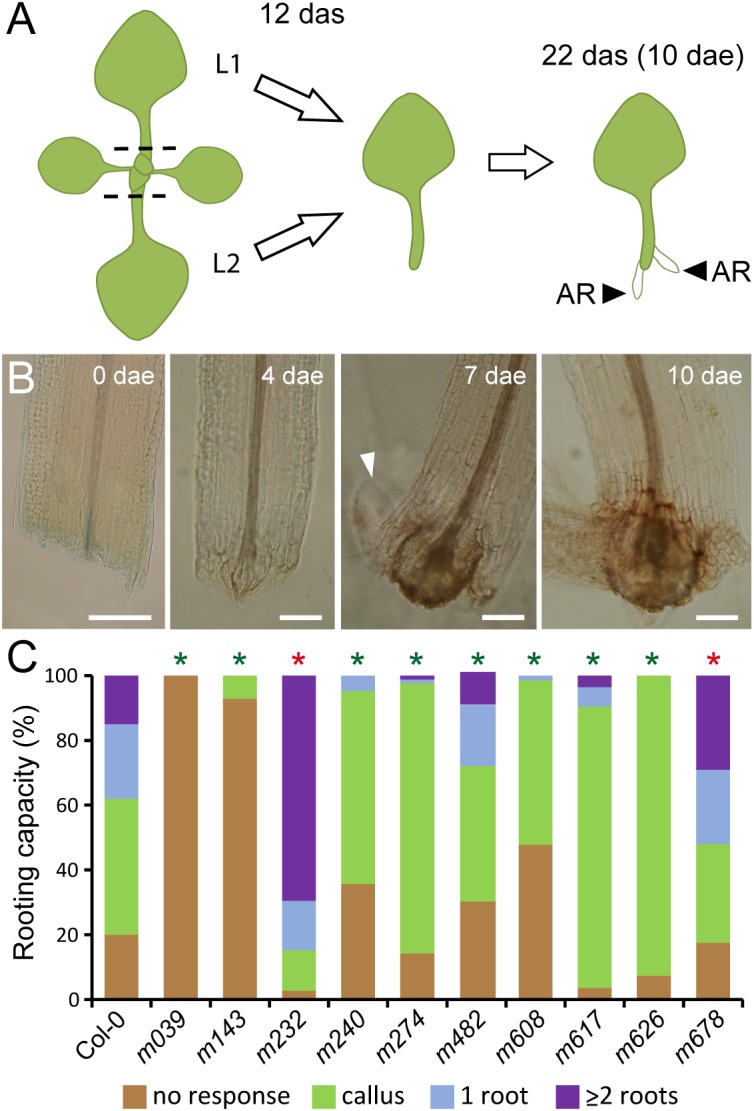
De novo root formation in selected mutants. (A) Schematic representation of de novo root formation in Arabidopsis whole leaf explants. Dashed lines indicate the cut site. AR: adventitious root; L1 and L2: first node and second node vegetative leaves, respectively. (B) Morphological changes at the petiole base during de novo root formation in the Col-0 background. Arrowhead indicates the emergence of a root primordium. Scale bars: 200 μm. (C) Rooting capacity in leaf explants of selected mutants at 10 dae. Asterisks indicate significant differences (LSD; p-value < 0.01) with the Col-0 background; those with lower AR values are shown in green and those with higher AR values are in red.